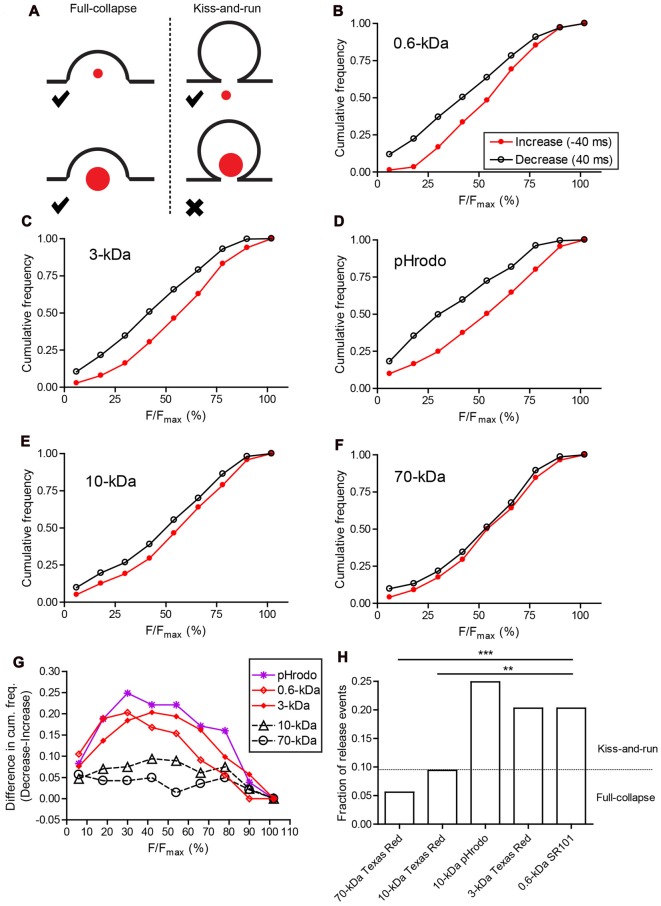
Two modes of synaptic vesicle exocytosis. (A) Schematic image illustrating that small dyes can be released by both full-collapse and kiss-and-run exocytosis, whereas large dyes can only be released by full-collapse. (B–F) Cumulative histograms of relative fluorescence values measured in individual vesicles one 40-ms frame before the peak (increase; red filled circles) and one frame after peak fluorescence was attained (decrease; black open circles). (G) Differences in cumulative frequency between fluorescence decrease and increase from (B–F) used to assess the fraction of events due to release. (H) Bar graph of release fractions determined from the maximum difference in cumulative frequency for each dye in (G). Fractions of release events seen with SR101 (N = 143 events), 3-kDa Texas Red (N = 315), and pHrodo (N = 181) were significantly greater than fractions of release events seen with 10-kDa (N = 213) and 70-kDa Texas Red (N = 142). **P < 0.01, ***P < 0.001 (z-test: pHrodo vs. 10-kDa Texas Red: P < 0.0001; pHrodo vs. 70-kDa Texas Red: P < 0.0001; SR101 vs. 10-kDa Texas Red: P = 0.0034; SR101 vs. 70-kDa Texas Red: P = 0.0002; 3-kDa Texas Red vs. 10-kDa Texas Red: P = 0.0008; 3-kDa Texas Red vs. 70-kDa Texas Red: P < 0.0001).